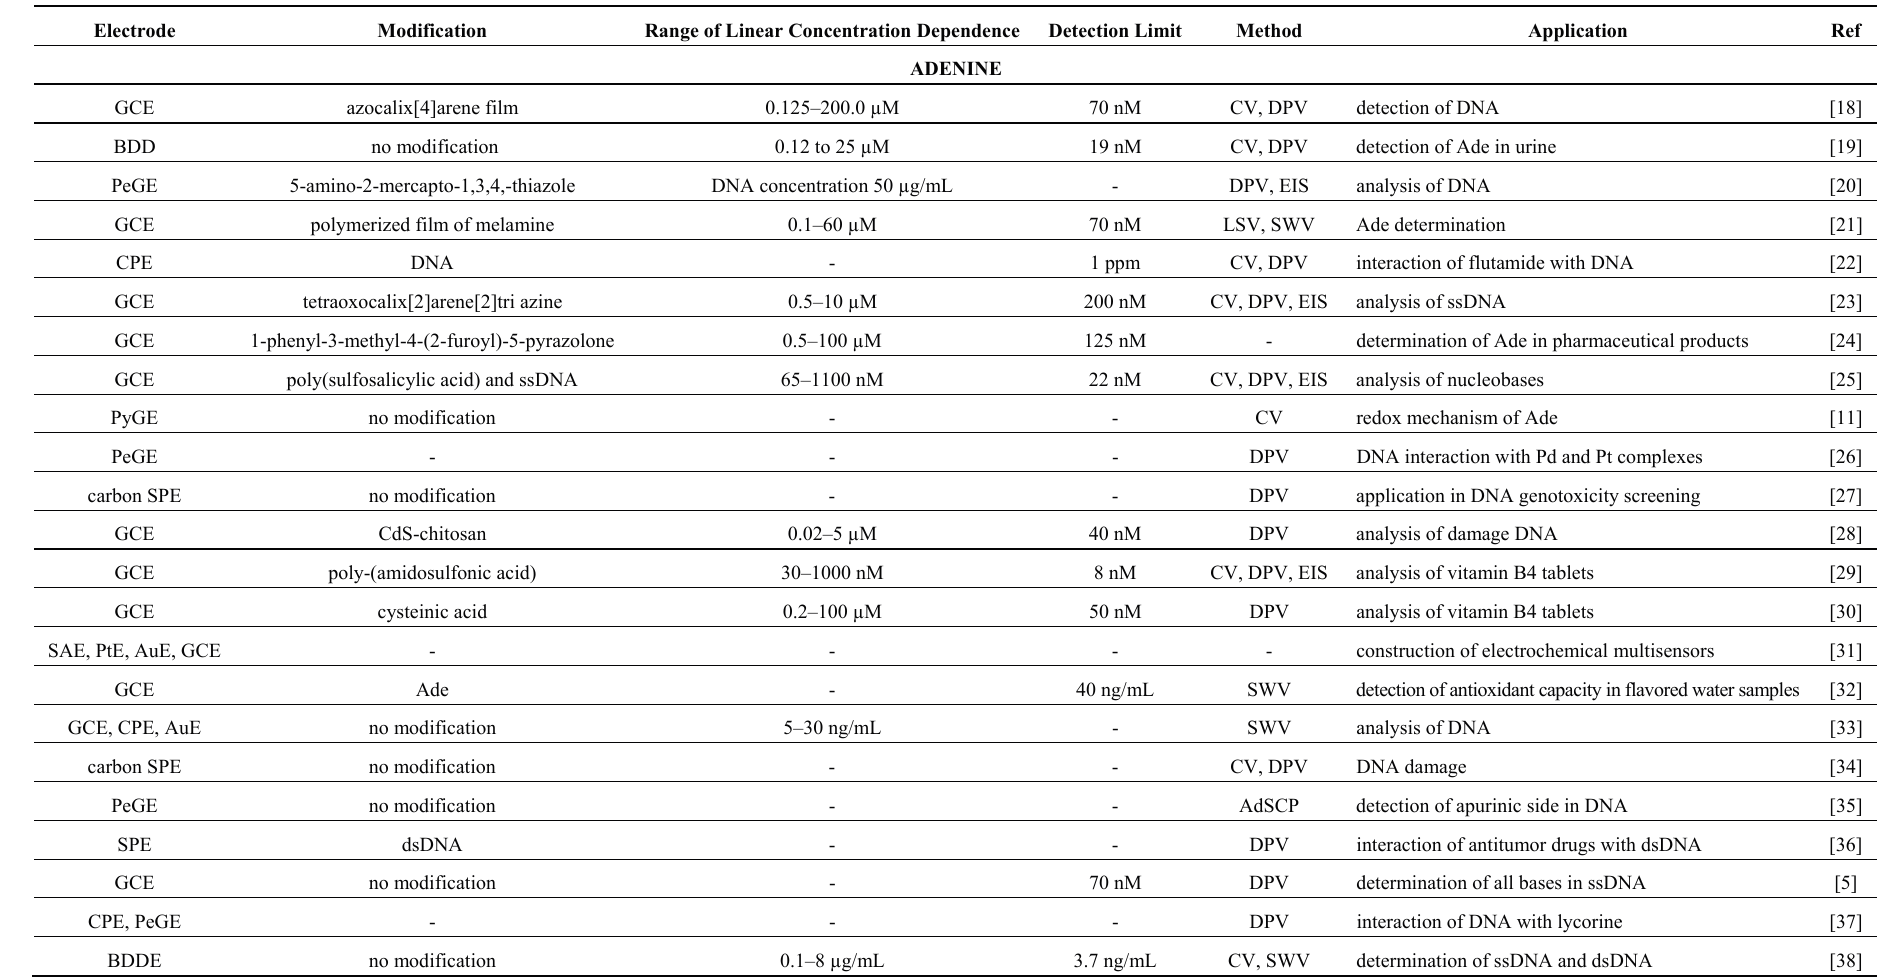
Table 1. Adenine and